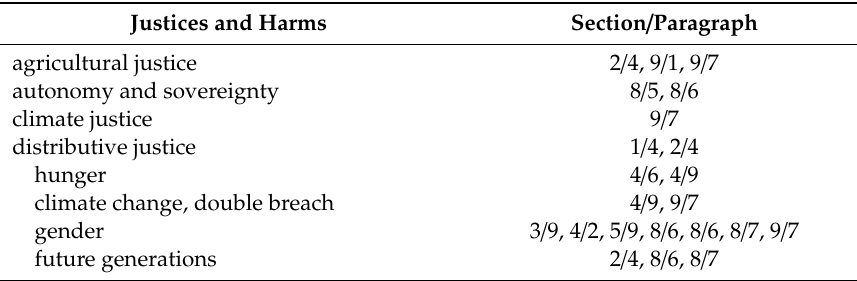
Table A1. Justice issues, rights, and